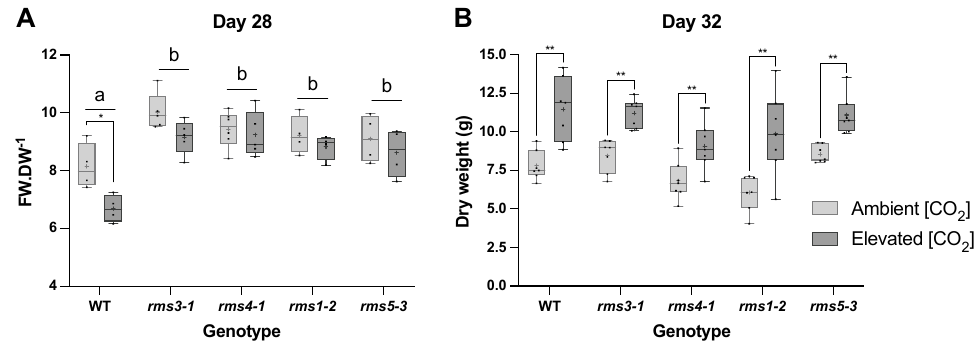
Figure 3. The effect of high CO 2 on the fresh weight/dry weight ratios ( A ) and dry weights ( B ) of wild type peas and mutants defective either in strigolactone (SL) synthesis ( rms1 - 2 and rms5-3 ) or signaling ( rms3 - 1 and rms4-1 ). Plants were grown for 28 days (fresh weight/dry weight) or 32 days (dry weights) either under ambient (420 ppm CO 2 ) or high CO 2 (750 ppm). Different letters indicate a statistically significant difference ( p < 0.05) between genotype at each time point, while a significant difference between [CO 2 ] within genotype is indicated as: * p < 0.05; ** p < 0.01 ( n = 5). Mean indicated as +. All the lines had similar levels of leaf glucose, fructose, sucrose and starch when plants were grown in air (Figure 4). Growth under eCO 2 significantly increased the levels of sucrose and starch in all the lines (Figure 4). While eCO 2 also tended to increase the levels of leaf hexoses (glucose and fructose), this effect was only significant in some lines (Figure 4).